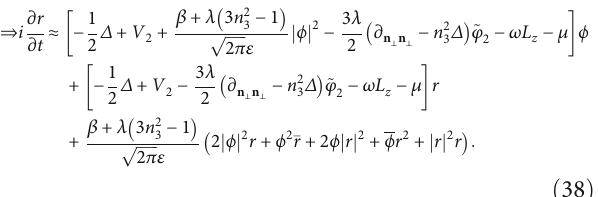
Step 1 of Algorithm 1 Step 2 of Algorithm